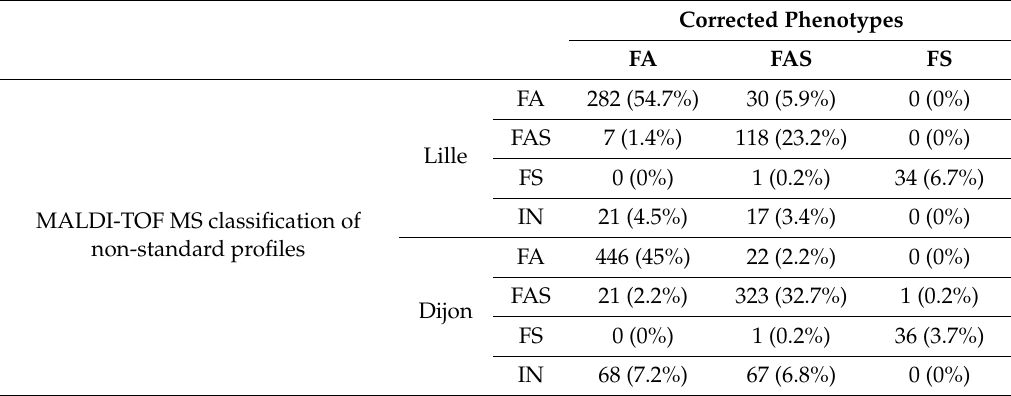
Table 3. Classification by the algorithm of profiles considered to be nonstandard in a visual assessment. Some spectra could not be interpreted by the algorithm (IN). The percentage is based on the number of profiles considered to be nonstandard (780 profiles at Lille and 985 at Dijon). Corrected Phenotypes FA FAS FS